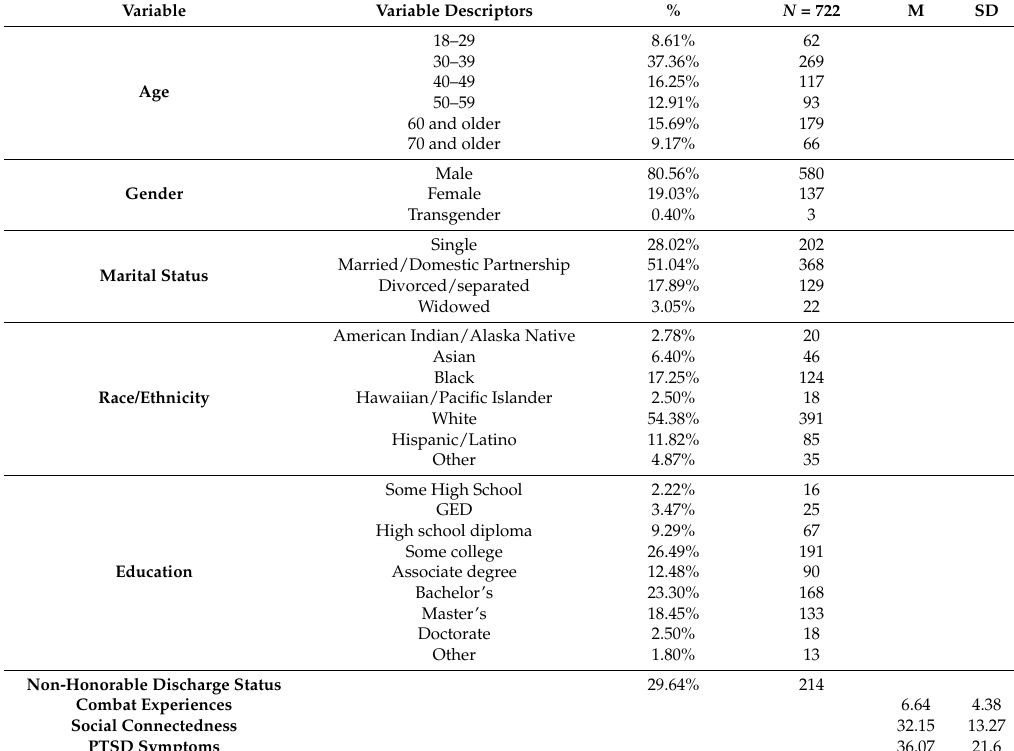
Table 2. Sample descriptive